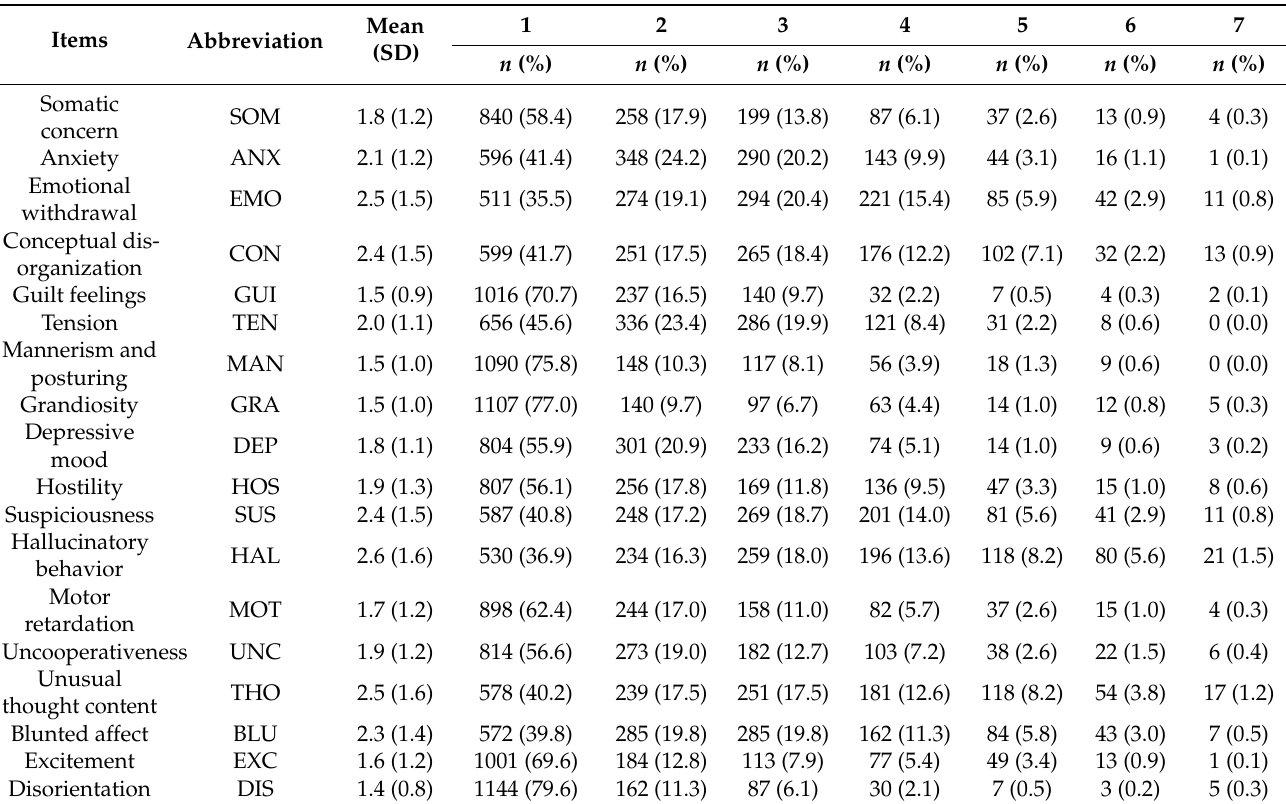
Table 2. Mean (SD) and % score of the Brief Psychiatric Rating Scale items ( n =